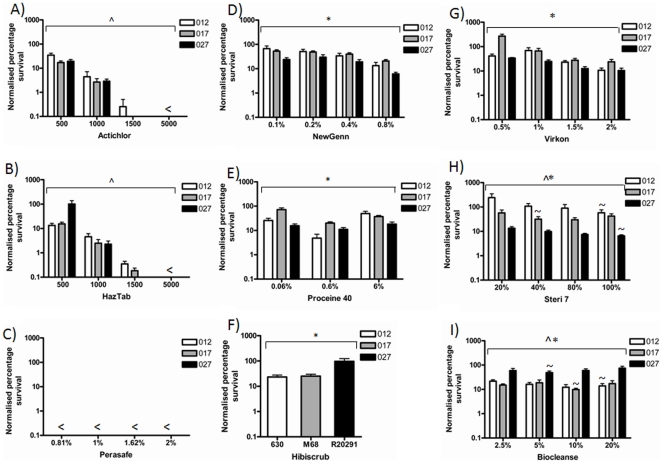
Exposure of C. difficile PCR-ribotype 012, 017 and 027 strains to disinfectants.Percentage survival after 30 minute exposure to A) Actichlor® at 5000 ppm, 1500 ppm, 1000 ppm and 500 ppm. B) Haztab® at 5000 ppm, 1500 ppm, 1000 ppm and 500 ppm. C) Perasafe® at 2%, 1.62%, 1% and 0.81%. D) Virkon® at 2%, 1.5%, 1% and 0.5%. E) Biocleanse® at 20%, 10%, 5% and 2.5%. F) Newgenn® at 0.8%, 0.4%, 0.2% and 0.1%. G) Proceine 40® at 6%, 0.6% and 0.06%. H) Steri 7® at 100%, 80%, 40% and 20%. I) Hibiscrub® at 50%. The survival was calculated as a percentage of the heat resistant spore counts from unchallenged cultures. Data consists of three biological and two technical replicates from separate cultures. <indicates survival was below the limit of detection of the assay (25 CFU/ml). Statistical analysis using linear regression (r2) and an interaction test (Chi2) was performed using the statistical program Stata 12. Bracket ∧ indicate a significant difference in concentration independent of PCR-ribotype (p<0.01), Bracket * indicates a significant difference between PCR-ribotypes independent of concentration (p<0.01) and Bracket ∧* indicates a significant difference between PCR-ribotypes in a concentration dependent manor (p<0.01).